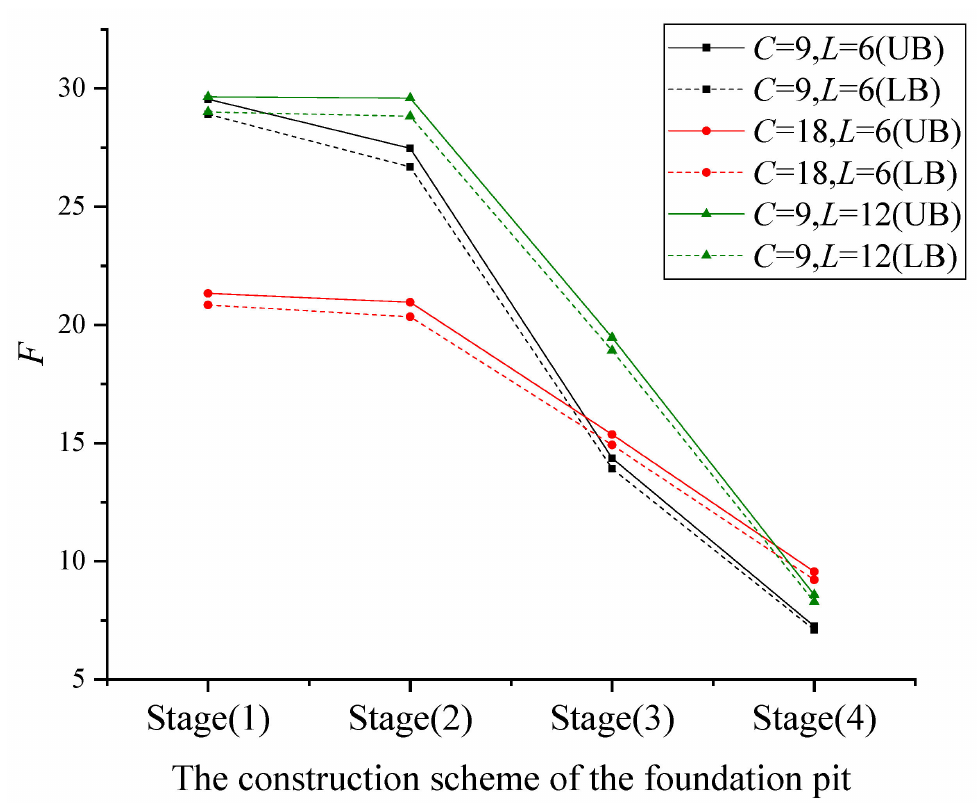
Figure 8. The safety factor of the global stability under each stage. The global failure mechanism of adjacent construction of the foundation pit and the twin shield tunnels changes accordingly with the construction stage. In Figure 9, the blue structures show the underground diaphragm wall and shield tunnels, respectively. The different colors of the shear dissipation contours represent the value of the shear dissipation energy. The shear dissipation energy is larger when the color of the shear dissipation contours is more approximate to red. As shown in Figure 9a, due to the shallow excavation depth, structure of foundation pit is relatively stable when the foundation pit construction reaches the stage (1). After reduction in strength of structural element, the twin shield tunnels collapsed first. As shown in Figure 9b, the structure of the foundation pit also begins to lose stability when the foundation pit construction reaches stage (2). It can be seen from Figure 9c,d that the foundation pit collapses first under the deep excavation depth and the left one of twin shield tunnels is also influenced by the failure of foundation pit, and the incremental displacement vector under each stage shown in Figure 10 depicts the deformation of surrounding soil of adjacent construction, and the incremental displacement vector represented by the green arrows corresponds well to the failure mechanism under the four